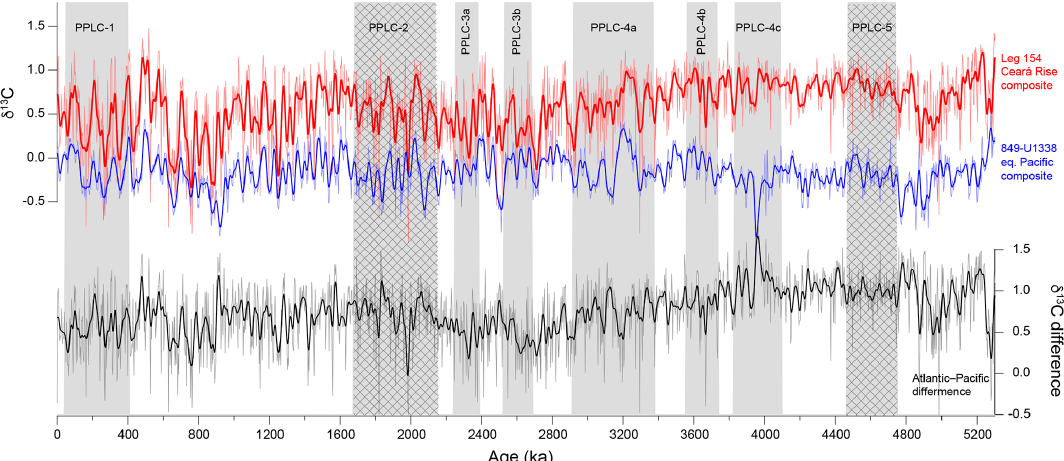
Figure 10. δ 13 C records from Ceara Rise (Atlantic, red) and the site 849–U1338 composite (Pacific, blue), and the Atlantic–Pacific δ 13 C difference (black). The PPLC-4 dissolution interval falls on the period of decline of the Atlantic Pacific difference caused by a decrease in Atlantic δ 13 C of about 0.7‰ between 4000 and 2500ka and an increase in Pacific δ 13 C of about 0.4‰ over the same